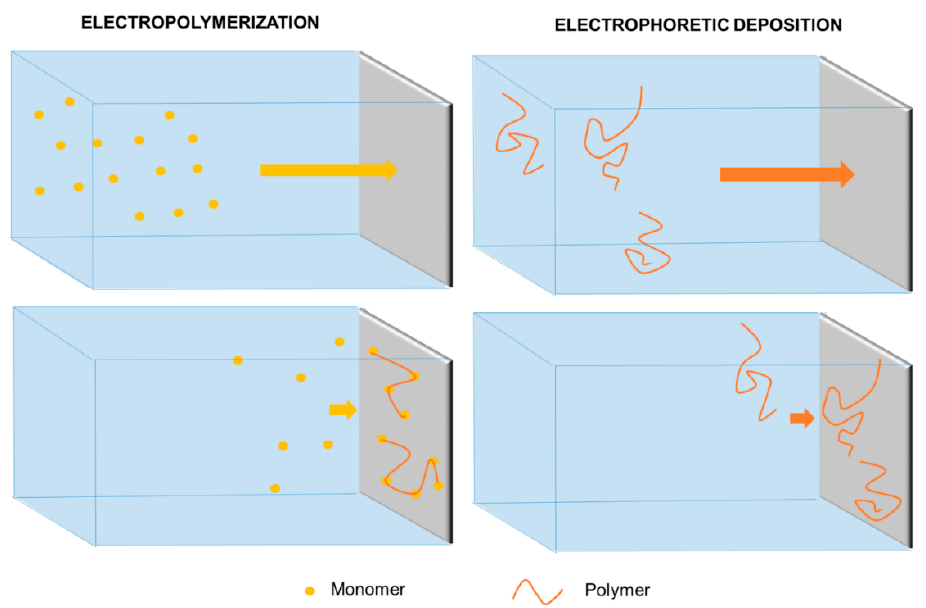
Figure 1. Schematic difference between electropolymerization and electrophoretic deposition of polymers to the metal electrode.